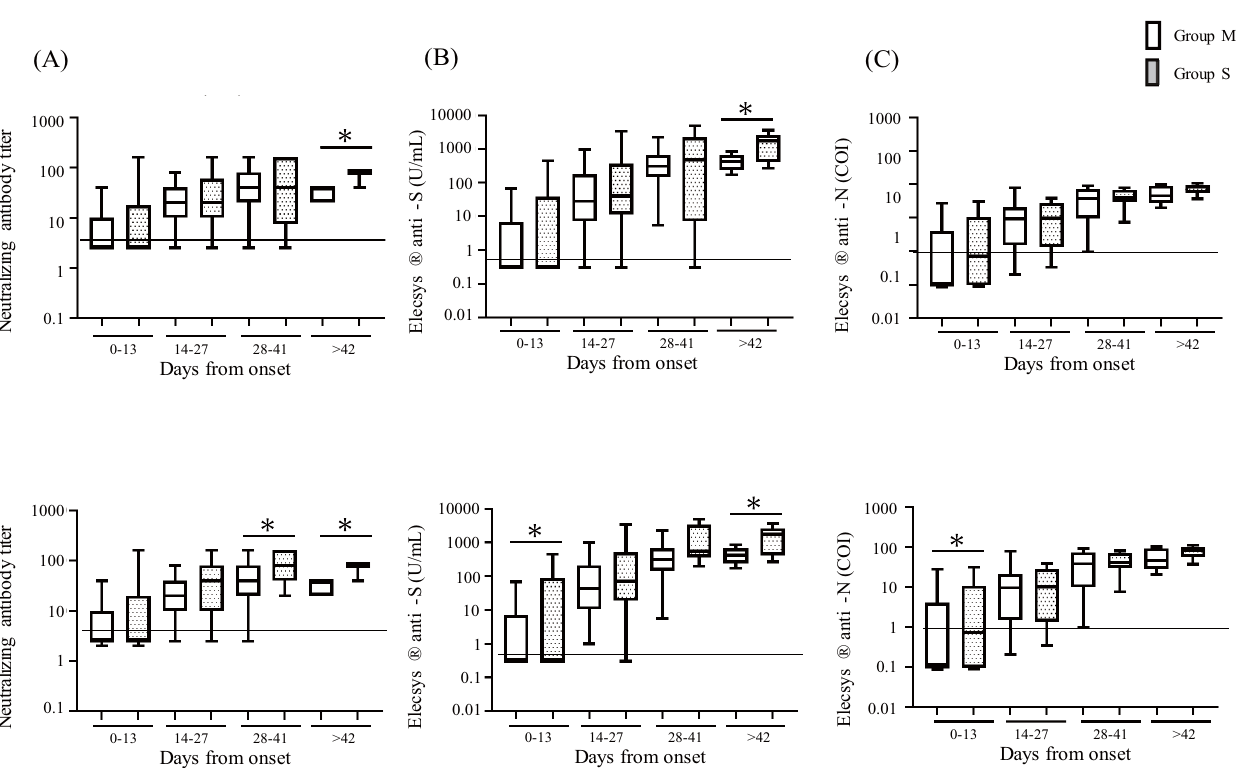
Fig 2. Comparison of antibody levels between Group M (mild + moderate) and Group S (severe + critical). One hundred forty-six serum samples from COVID-19 patients at various time points after the onset of symptoms were tested by neutralization assay, Elecsys 1 anti-S, and Elecsys 1 anti-N, and were examined for changes over time. All cases of antibody values of neutralization assay (A), Elecsys 1 anti-S (B), and Elecsys 1 anti-N (C) in Group M (n = 84) and S (n = 62) subjects were shown. Four cases receiving immunosuppressive therapy (1 in Group M; 3 in Group S) were excluded and the antibody values of neutralization assay (D), Elecsys 1 anti-S (E), and Elecsys 1 anti-N (F) were shown. Open bars represent Group M and dotted bars represent Group S. Wilcoxon signed-rank test was performed. The data were presented as median with interquartile ranges (IQR). � p < 0.05. The vertical axes are in logarithmic